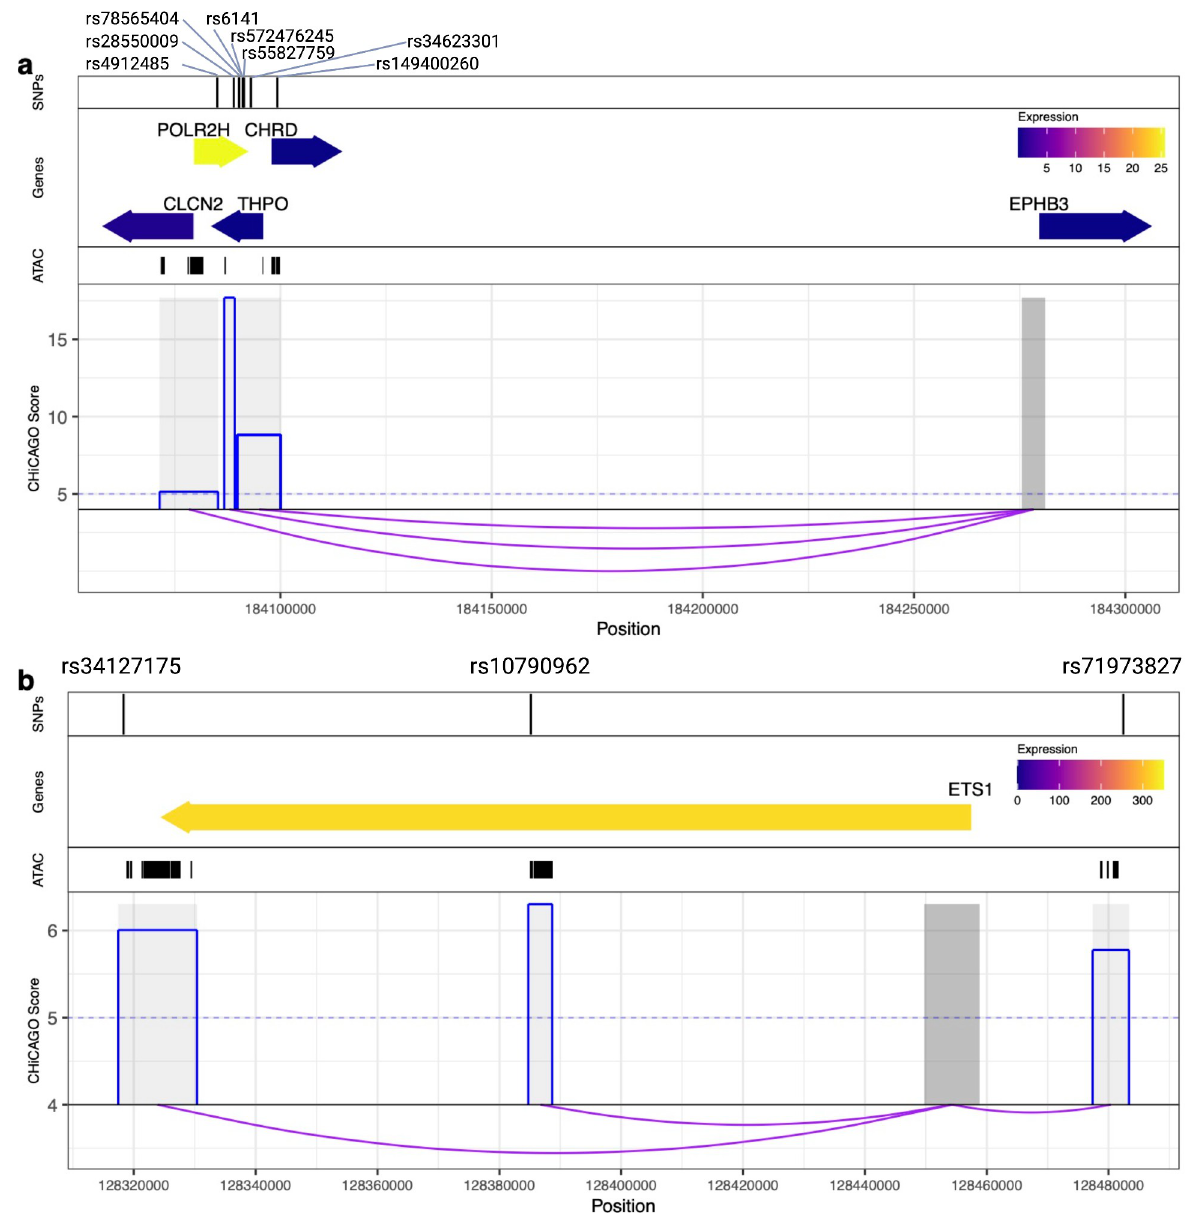
Fig 4. SIP subnetworks show the complex regulation of promoters for important hematopoietic cell type genes. First panel: position of SNPs. Second panel: position of SIP bait or PIR target gene(s), where the color corresponds to their exponentiated BLUEPRINT gene expression (equivalent to RPKM) in the respective cell type. Third panel: cell type-specific ATAC-seq peaks. Fourth panel: CHiCAGO scores (blue) of the interactions (depicted by purple arcs) between the SIP bait (dark grey) and the SIP PIRs (light grey). (A) Example of a megakaryocyte SIP subnetwork for platelet count related variants. (B) Example of a naive CD4 T-cell SIP subnetwork for lymphocyte count related